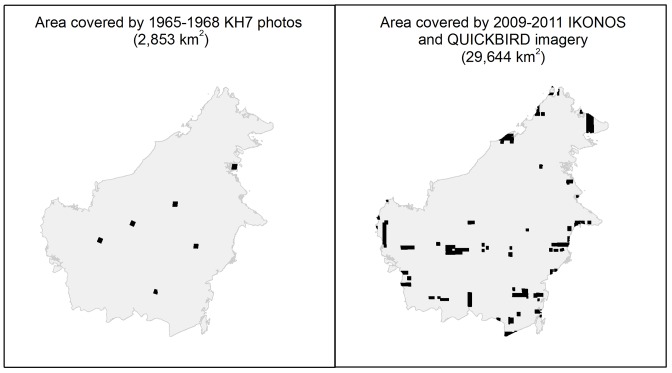
Map showing the areas where validation of the forest and plantation maps was performed.Area covered by 1965–68 KH7 imagery (Black) used to validate the 1973 forest map in Left Panel. Area covered by 2010 IKONOS and QUICKBIRD imagery (Black) used to validate the 2010 forest and plantation maps in Right Panel.